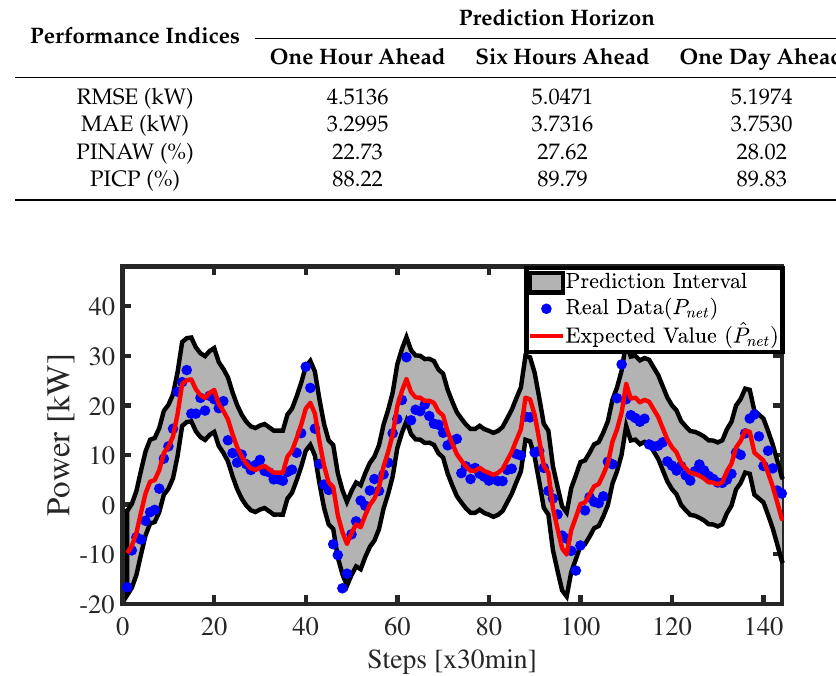
Figure 3. One-day-ahead prediction interval for P net tuned at PICP =